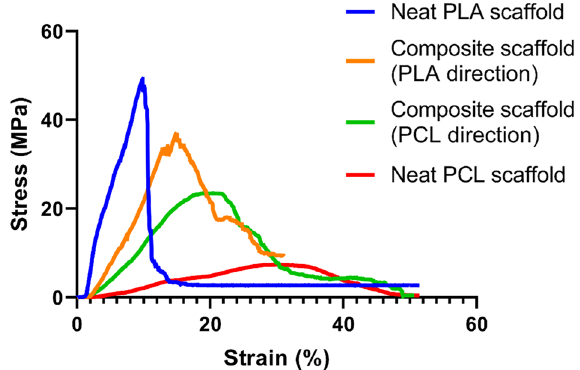
Figure 5. Stress vs. strain curve for 3 scaffolds (the test is conducted in two directions for the composite PLA/ PCL scaffold, one is the direction of printing the PLA fibers and the other is the direction of printing the PCL fibers which is perpendicular to the first direction) (number of samples for each measurement = 3) (Statistical analysis with one-way ANOVA shows statistical significance with p-values less than 0.05).